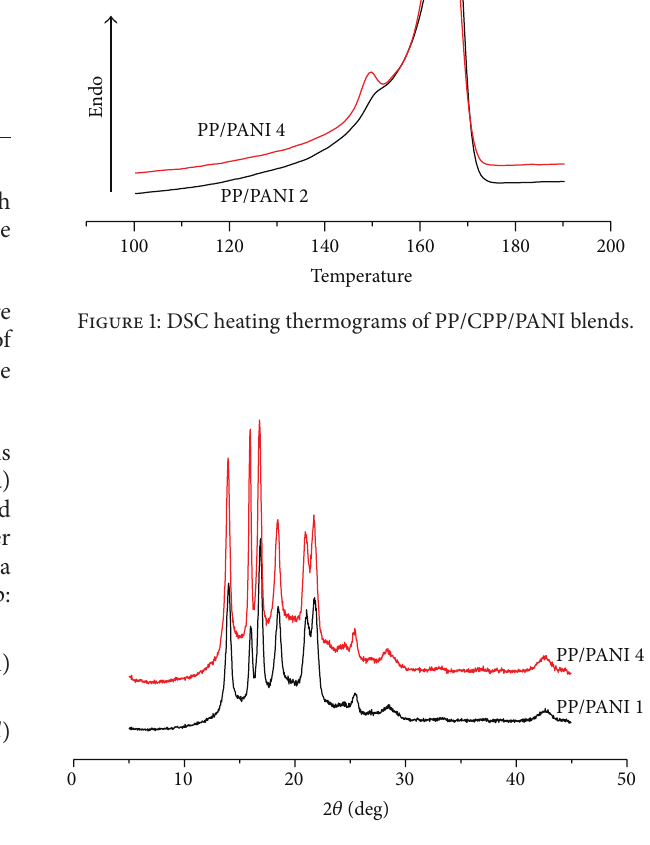
Figure 2: WAXD patterns of PP/PANI 1 and PP/PANI